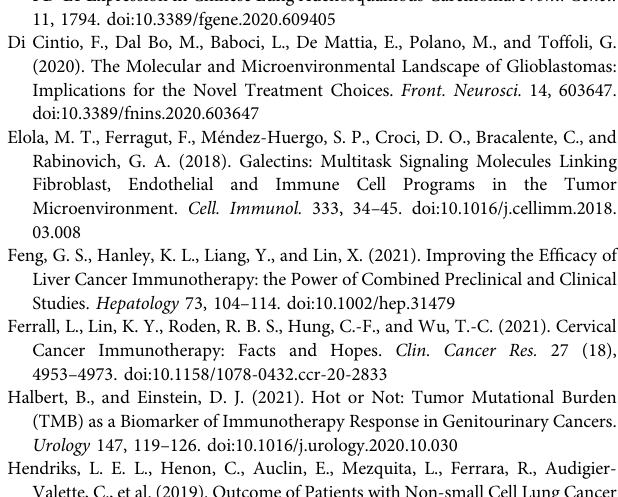
Supplementary Figure S1 | LASSO coef fi cient pro fi les and the tuning parameter. (A) LASSO coef fi cient pro fi les of the 15 hub genes. (B) The selection of the tuning parameter (lambda) in the LASSO model by tenfold cross-validation based on minimum criteria for OS. Supplementary Figure S2 | K-M curve analyses between risk score and survival rate in (A) TCGA-GBM cohort, (B) TCGA-LGG cohort, (C) CGGA-GBM cohort, (D) CGGA-LGG